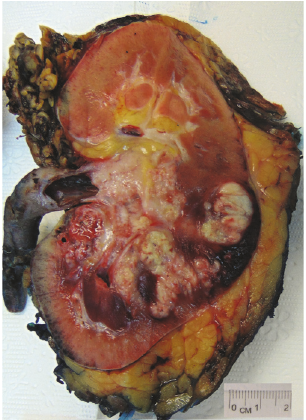
Figure 1: Computed tomography with contrast (CT) coronal image demonstrates a heterogeneously enhancing hypodense right renal mid pole mass (red arrow) occupying the renal cortex and renal pelvis with mild surrounding fat stranding.